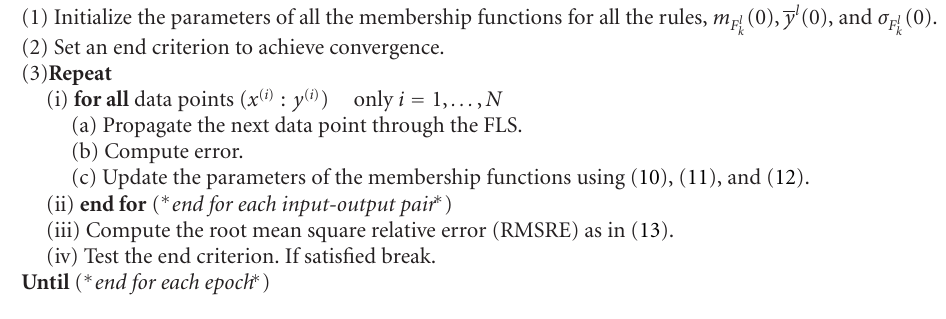
Algorithm 3: Back propagation algorithm for